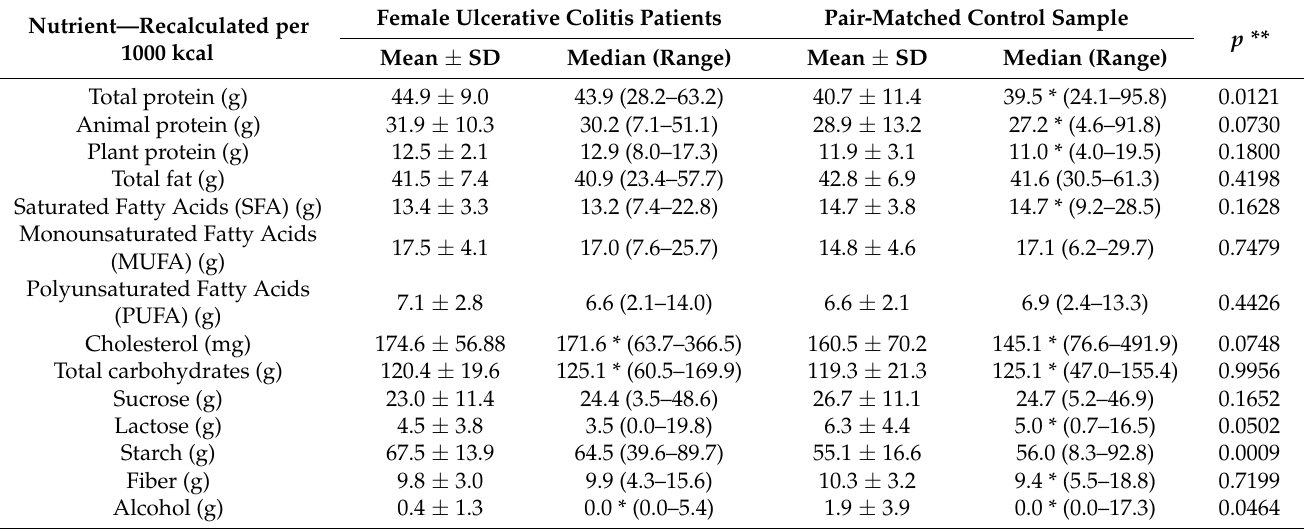
Table 2. The macronutrients intake recalculated per 1000 kcal in the studied Polish female ulcerative colitis individuals, in comparison with a pair-matched control